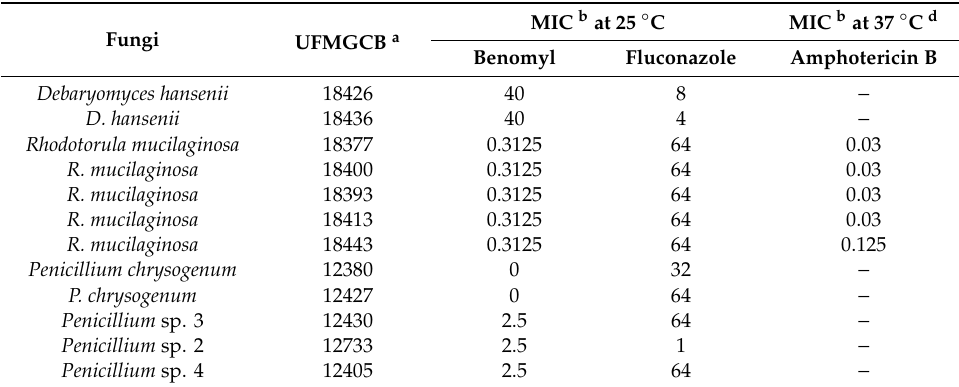
Table 3. The minimal inhibitory concentration of benomyl, fluconazole, and amphotericin B against fungi isolated from seasonal snow of